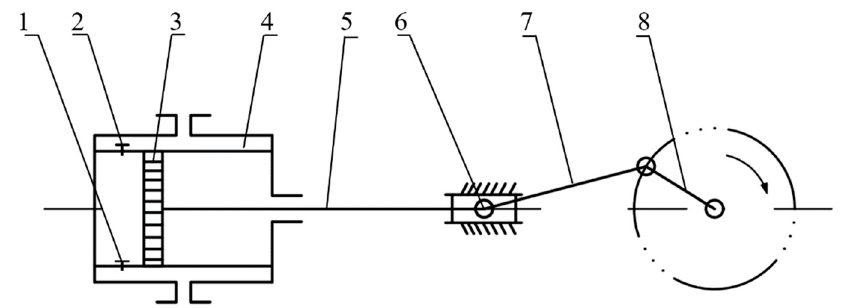
Figure 1. Principle of a one-stage reciprocating compressor. 1 — suction valve; 2 — discharge valve; 3 — piston; 4 — cylinder; 5 — piston rod; 6 — crosshead; 7 — connecting rod; 8 — crankshaft.